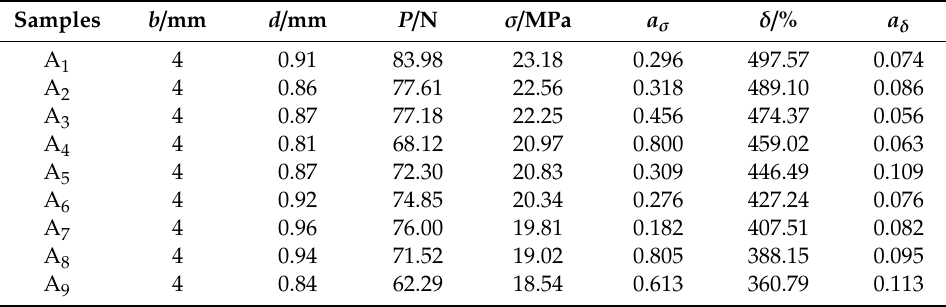
Table 2. Results of tensile test of samples from Factory